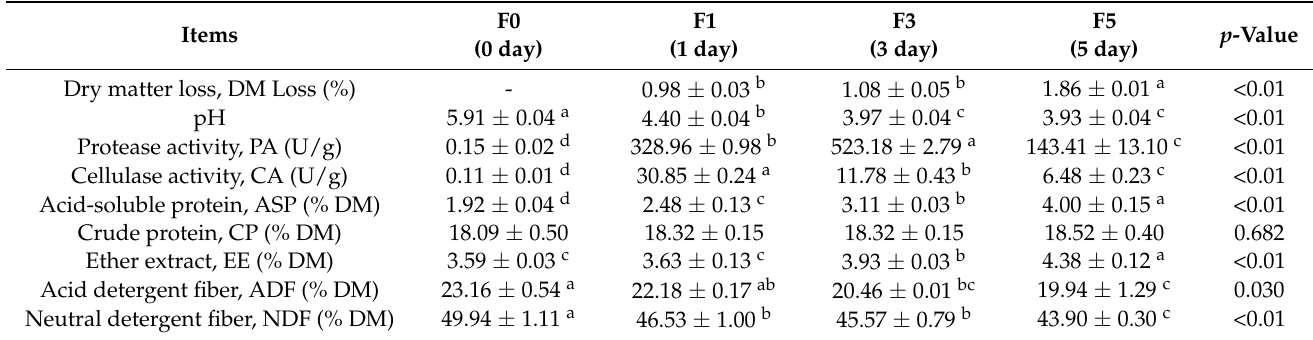
Table 3. Changes in the chemical composition of tea residue mixture at different times following fermentation by L. plantarum and B. licheniformis